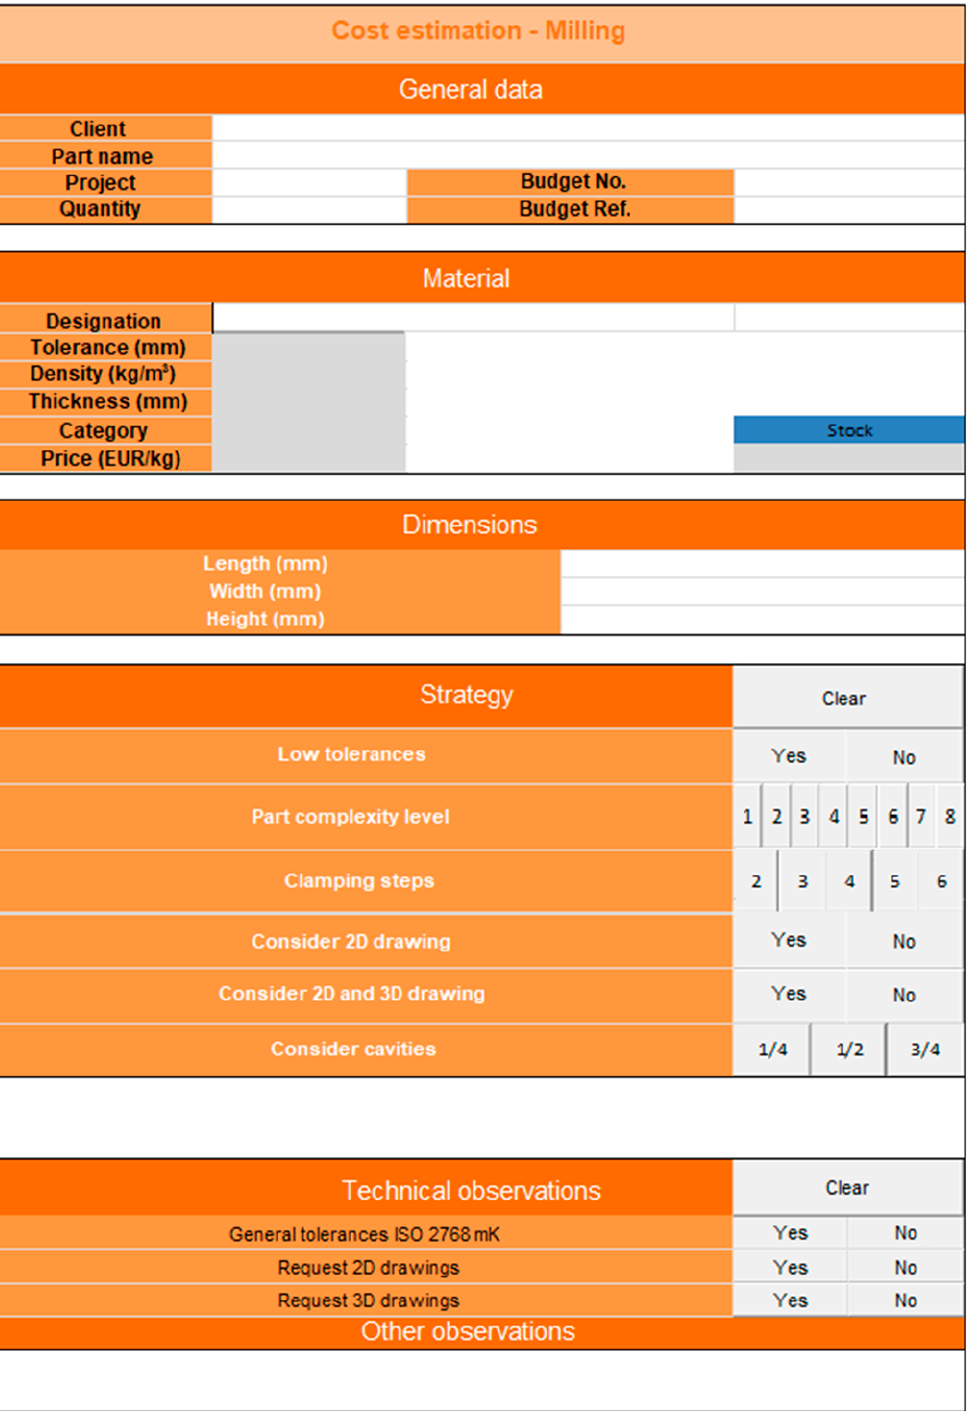
Figure 8. Output sheet of a machined polyethylene part produced for Case Study 1.